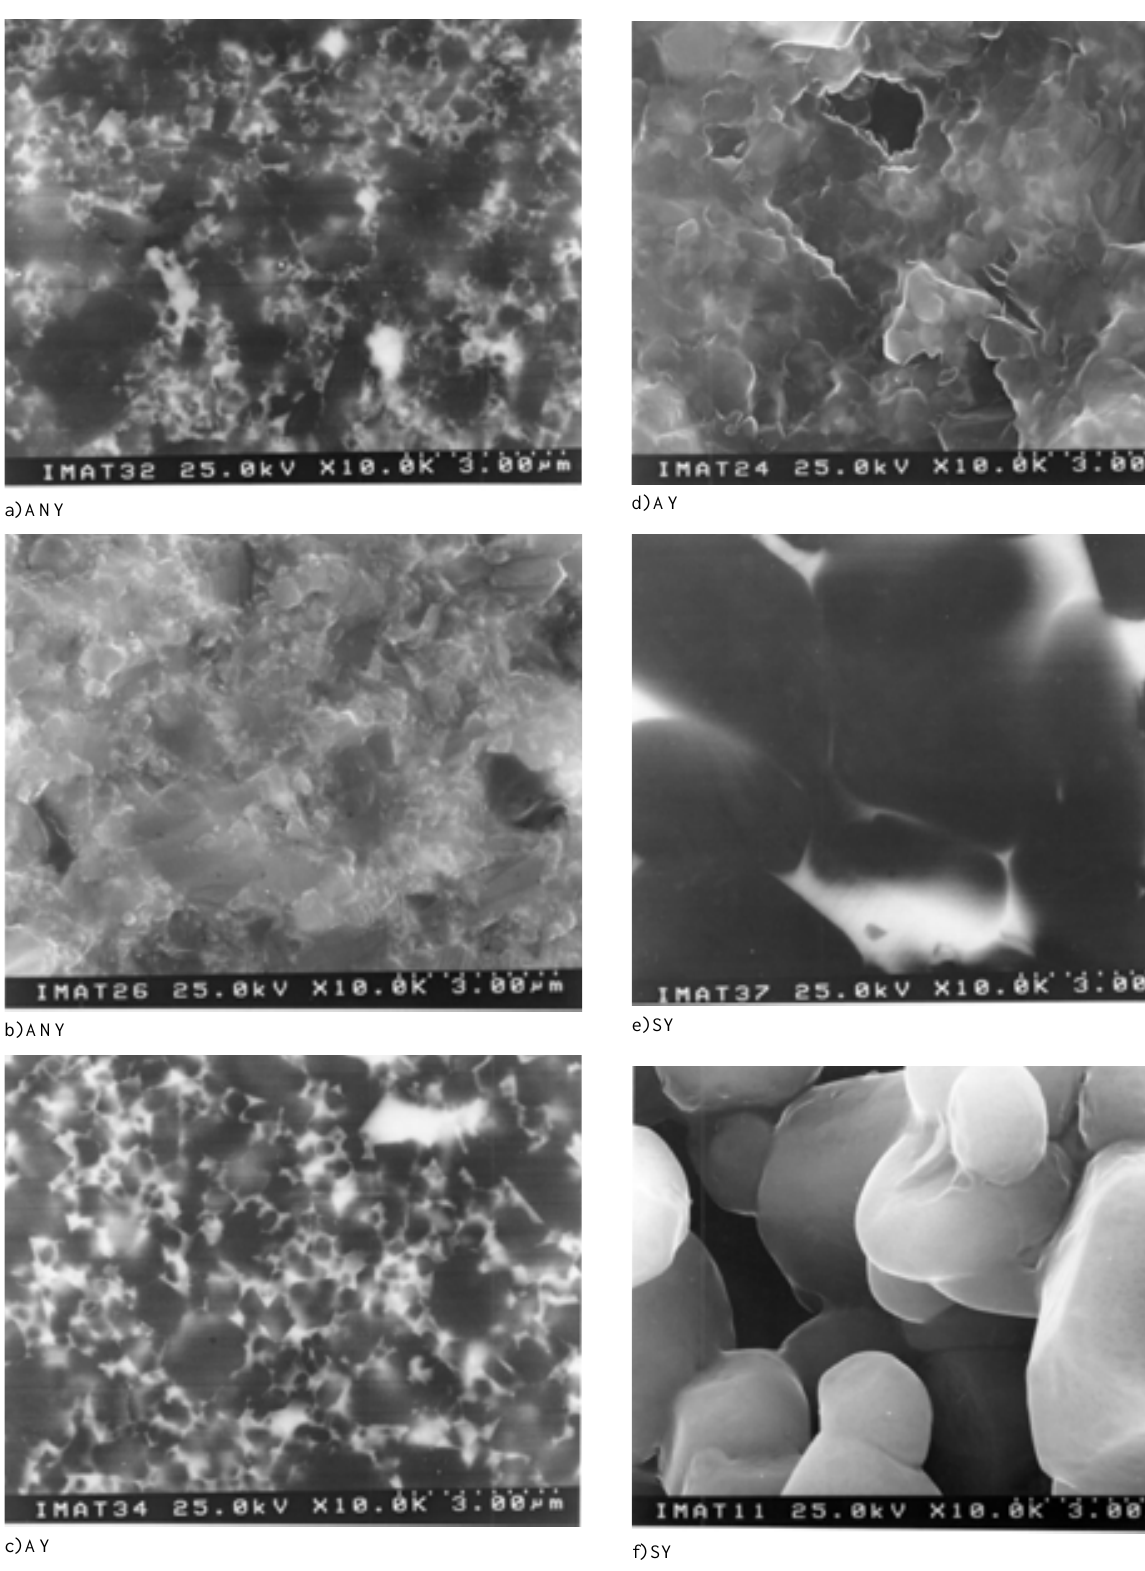
Figure 8. Microstructures (left) and fracture surfaces (right) of the samples sintered at 2100 °C, with additions of AlN/Y 2 O 3 (a, b), Al 2 O 3 /Y 2 O 3 (c, d) and SiO 2 /Y 2 O 3 (e,